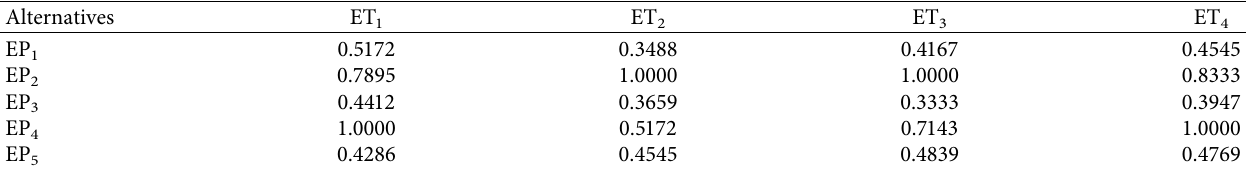
Table 10: GRC of each alternative from